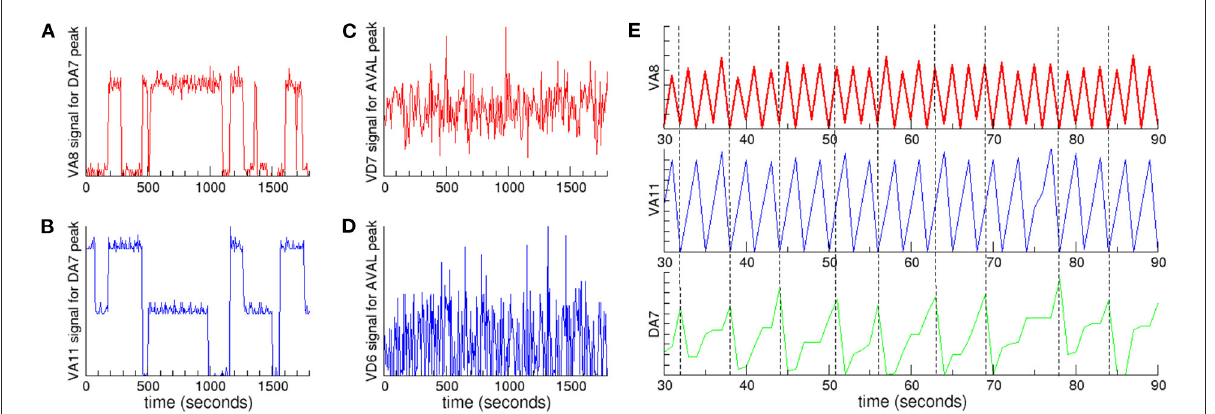
FIGURE4 Nested neuronal dynamics. We plot the signals of neurons in clusters (cid:127) 2 and (cid:127) 3 when a neuron selected from cluster (cid:127) 1 reaches its maximum: (A) VA8 signal (red) from cluster (cid:127) 3 and (B) VA11 (blue) from cluster (cid:127) 2 , when DA7 from cluster (cid:127) 1 reaches its maximum. Coupling between neurons in these clusters appears as regions characterized by signals with small fluctuations around a mean value. In contrast, when there is no coupling the signals present large fluctuations, as shown for example for the signals of (C) VD7 (red) from cluster (cid:127) 3 and (D) VD6 (blue) from cluster (cid:127) 2 , when AVAL from cluster (cid:127) 1 reaches its maximum. (E) A 60 s time interval from the data presented in (A, B) shows the hierarchical relation. The signals correspond to VA8 (red), VA11 (blue) and DA7 (green). The vertical dashed lines are a guide to the eye showing the time